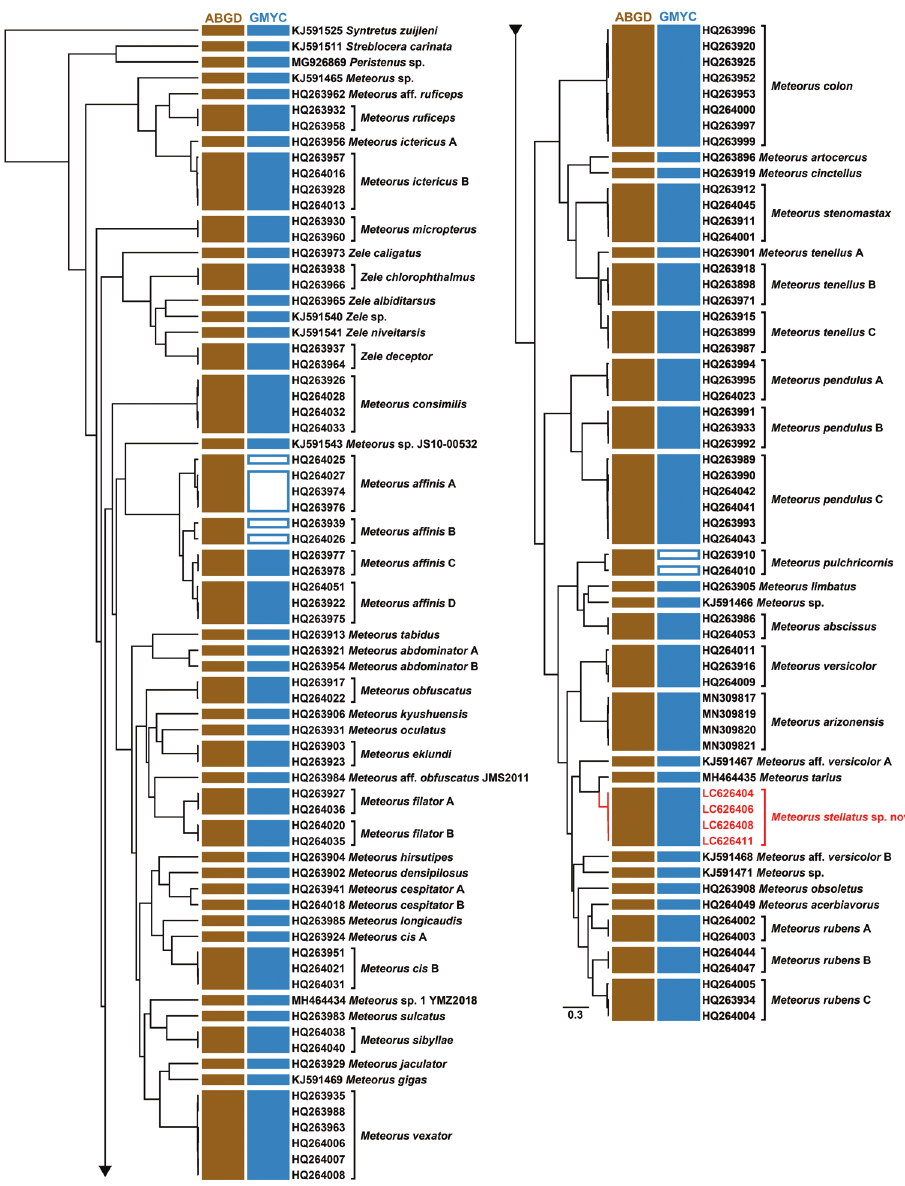
Figure 1. Species delimitation of Meteorus plus Zele plus closely related outgroups based on ABGD and GMYC methods, shown using a Bayesian consensus ultrametric tree generated using BEAST. Although the species delimitation was conducted using (1) Meteorus plus Zele plus outgroups, (2) Meteorus plus Zele , and (3) Meteorus sequences or topologies, all results were congruent; therefore, all results are shown as a summarized unit for each